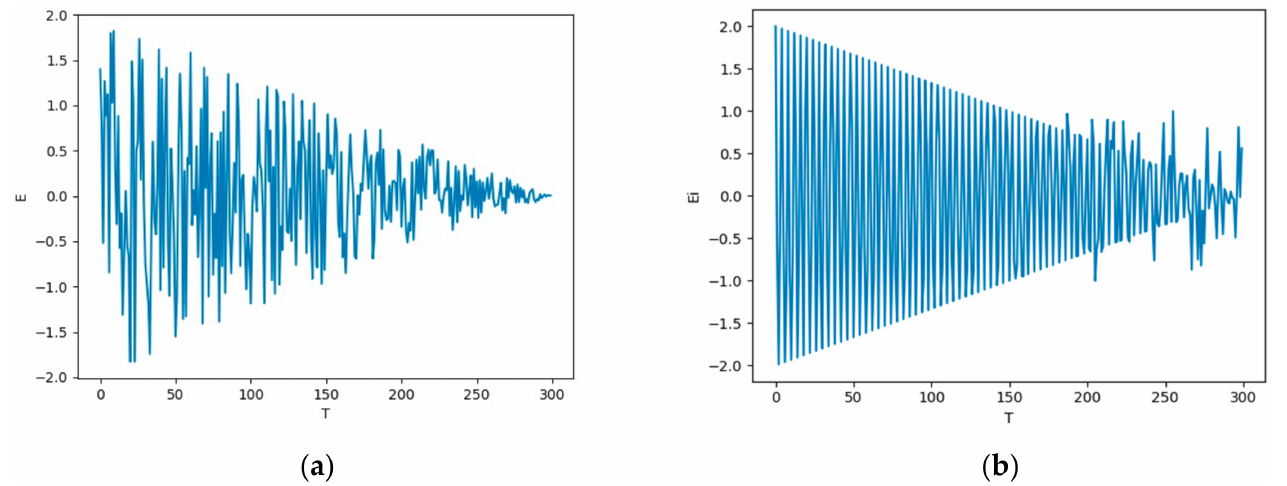
Figure 3. ( a ) Variation curve of E ; ( b ) variation curve of E i